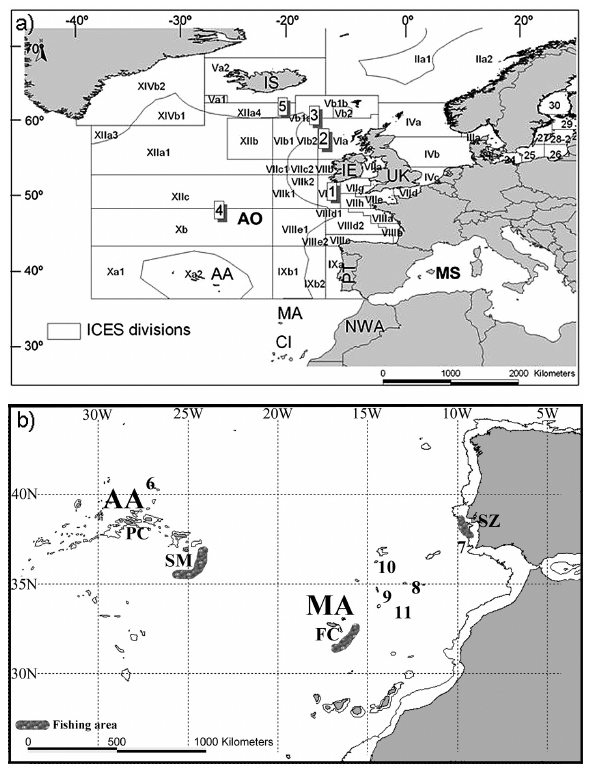
Fig . 1. – a) Map of the northeast atlantic with the ices divisions and b) the southern northeast atlantic with the sampling locations of black scabbardfish and the 1000 m isobath. aa, azores archi- pelago; ao, atlantic ocean; ci, canary islands; Fc, Funchal; ie, ireland; is, iceland, Ma, Madeira archipelago; Ms, Mediterranean sea; nWa, northwest africa; Pc, Pico island; Pt, mainland Por- tugal; sM, santa Maria island; sZ, sesimbra (mainland Portugal); uk, united kingdom; 1, Porcupine seabight; 2, rockall trough; 3,